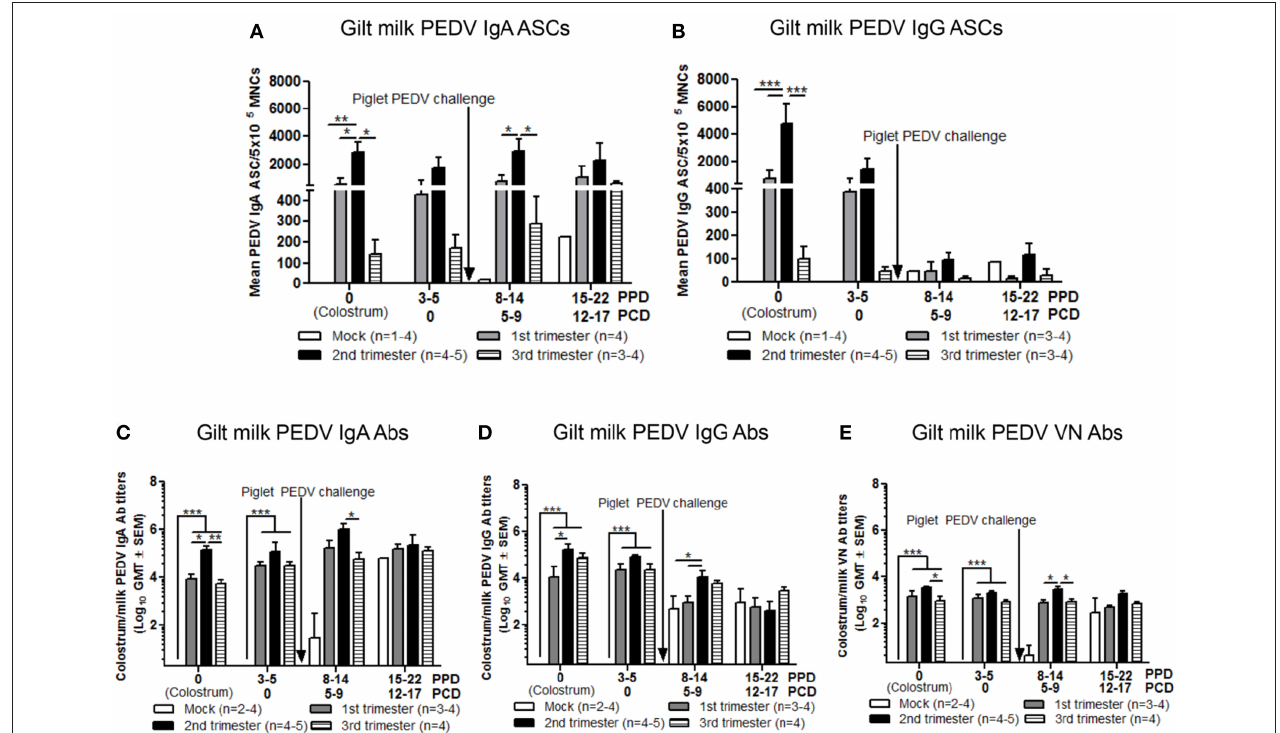
FIGURE 9 | Second trimester gilts had significantly increased circulating PEDV specific IgA and IgG antibody secreting cells (ASCs), PEDV IgA and IgG antibodies (Abs) and PEDV virus neutralizing (VN) Abs in colostrum/milk. (A) Milk mononuclear cells (MNCs) were isolated and added to PEDV ELISPOT plates to determine the PEDV specific IgA and (B) IgG ASCs. Whey PEDV (C) IgA and (D) IgG Abs were determined by ELISA while (E) whey PEDV VN Ab responses were determined by VN Ab assay. Gilts were sampled at postpartum day (PPD) 0, 3–5 (post challenge day [PCD] 0), 8–14 (PCD 5–9), and 15–22 (PCD 12–17). Asterisks indicate significant differences among treatment groups at the same time point (mean ± SEM). Statistical analysis was performed using the two-way ANOVA with repeated measures and Bonferroni’s correction for multiple comparisons. * P < 0.05, ** P < 0.01, *** P <